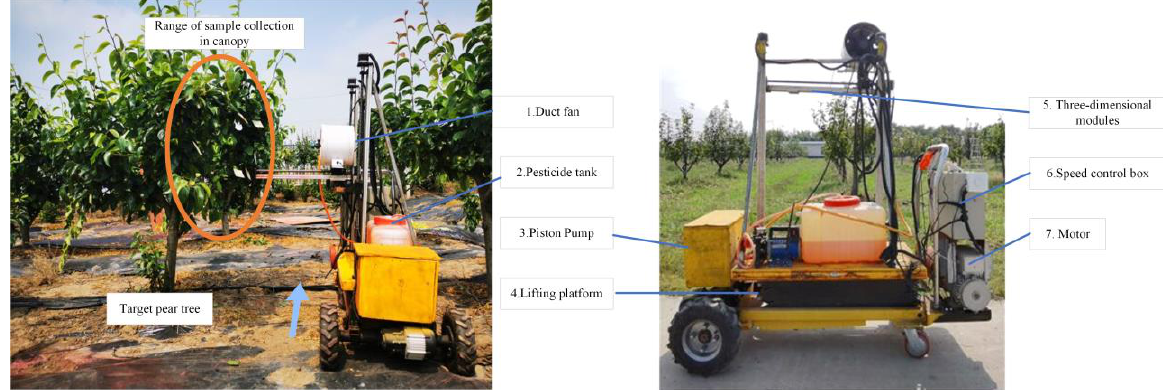
Figure 1. Three-dimensional mobile air-assisted spray platform.